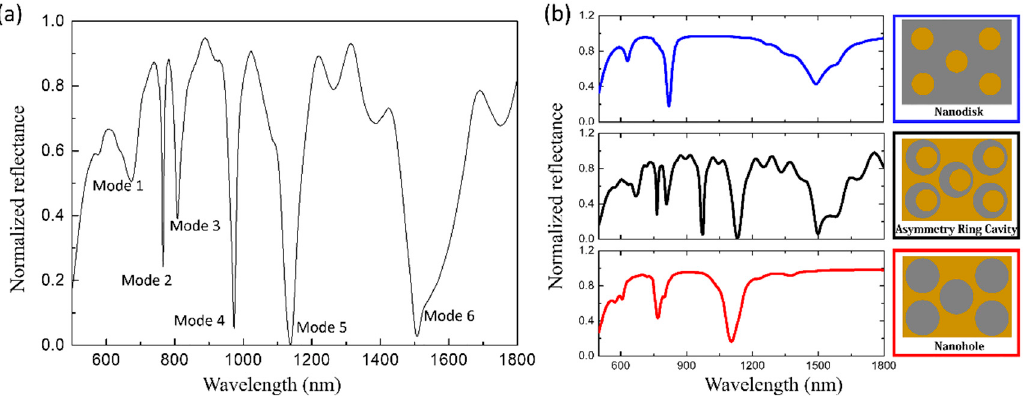
Figure 2. ( a ) The reflection spectrum of the designed structure. ( b ) The reflection spectrum of the nanodisk array (blue line) and the nanohole array (red line) structures which are deviated from the asymmetry ring cavity array. The illustrations are the schematic diagrams of the upper nanostructures corresponding to the spectrums. The environmental refractive index is 1.33.